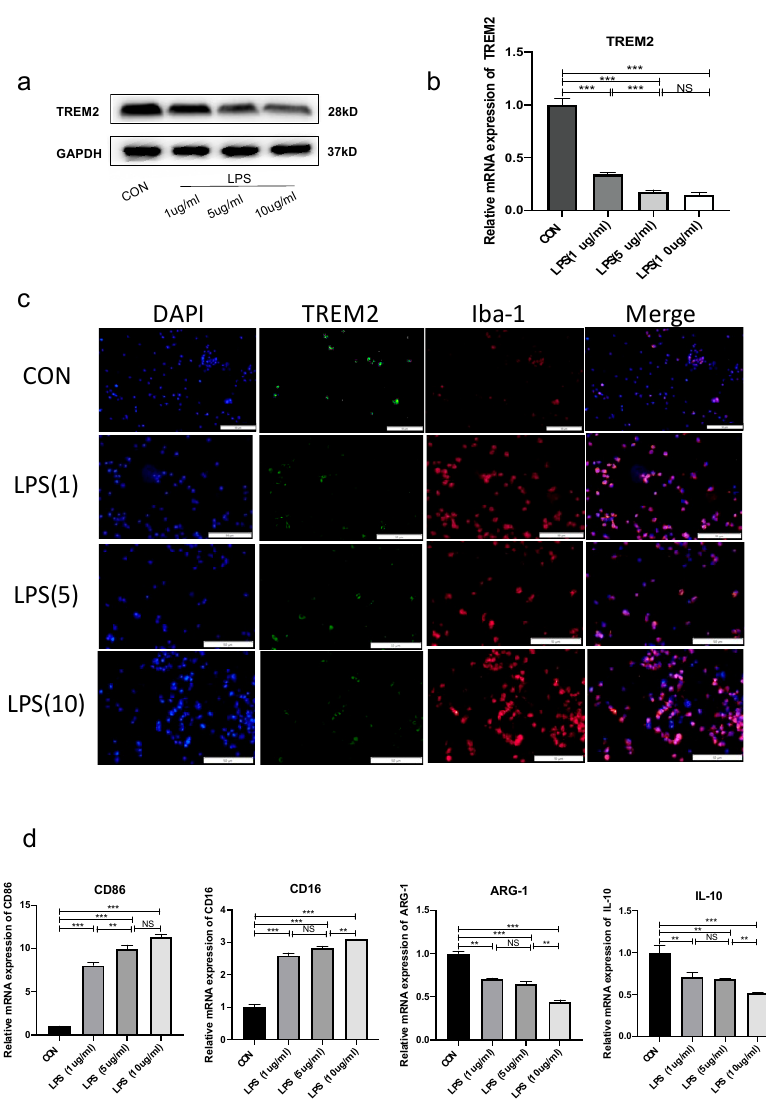
Figure 2. LPS reduced TREM2 expression and changed polarization of microglia in vitro. ( a ) Pro- tein expression of TREM2 after 24 h treatment of BV-2 cells with different concentrations of LPS. ( b ) mRNA expression of TREM2 after 24 h treatment of BV-2 cells with different concentrations of LPS. ( c ) Immunofluorescence staining of BV-2 cells with different concentrations of LPS. ( d ) mRNA expression of M1-type microglia markers (CD16 and CD86) and M2-type microglia markers (ARG-1 and IL-10) by PCR. NS indicates no statistical difference from the control group. ** p < 0.03, *** p < 0.01 compared with control, n = 6 mice per